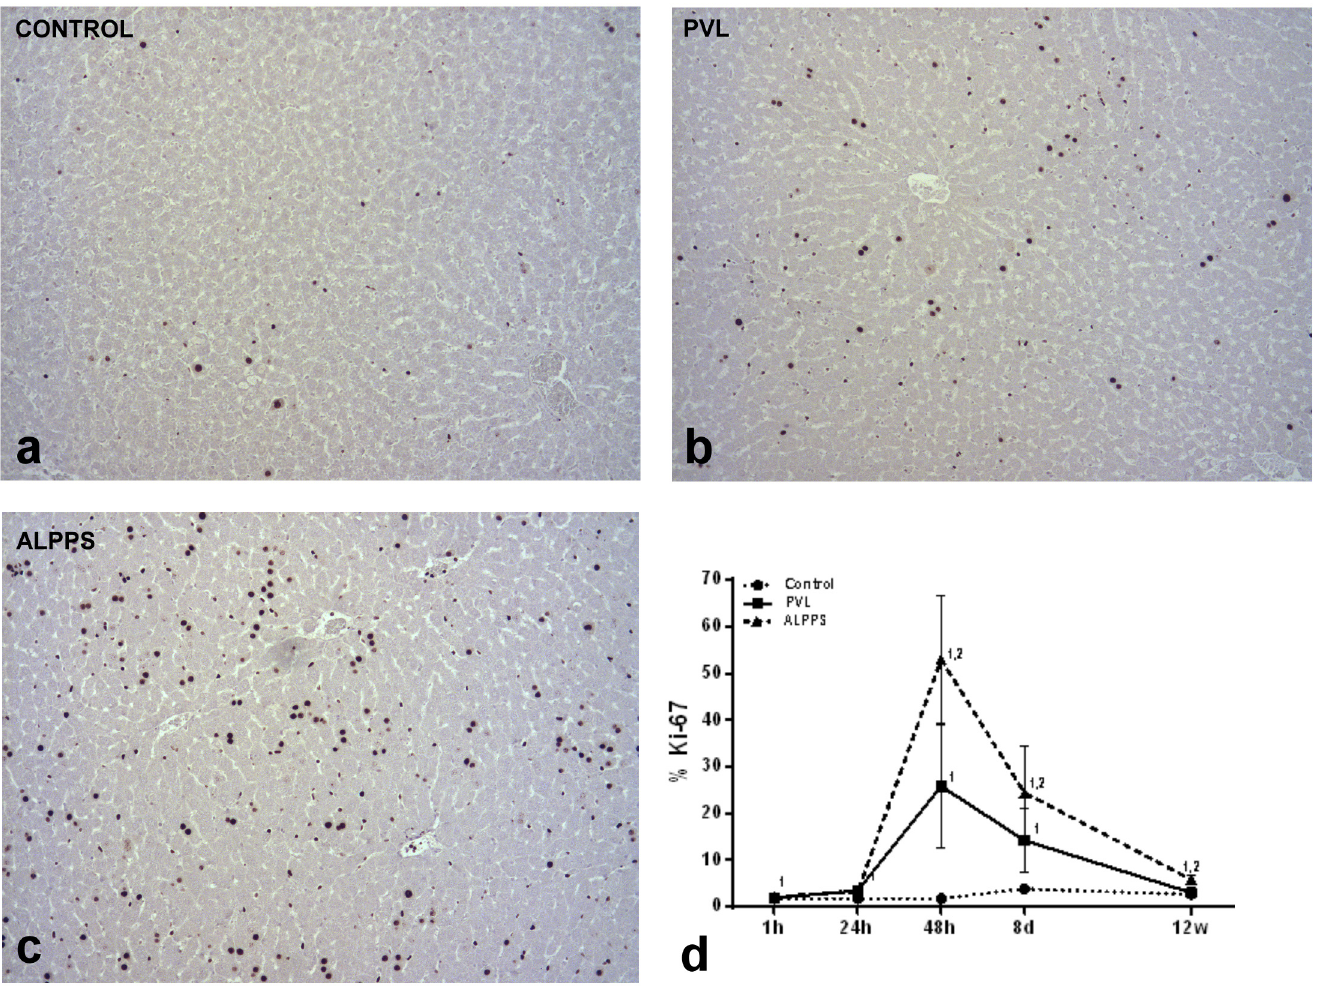
Fig 4. Representative microscopic images at day 8 post surgery, and temporal evolution of Ki-67 immunohistochemical expression in control, PVL and in ALPPS FLR. ( a ) In control liver, there is a little expression of Ki-67. ( b ) In PVL, there is an increase in Ki-67 in comparison with controls. ( c ) In ALPPS groups, there is a significantly increased expression in comparison with PVL at day 8. ( d ) The temporal evolution of Ki-67 expression showed a significant increase in expression of Ki-67 of ALPPS FLR, with a peak of expression at 48 hours. Mann-Whitney U-test (n = 6 animals per group). The numbers (1, 2) indicate significant differences of the considered group in comparison with control (1) and PVL (2) groups, respectively. A p value of < 0.05 was considered as